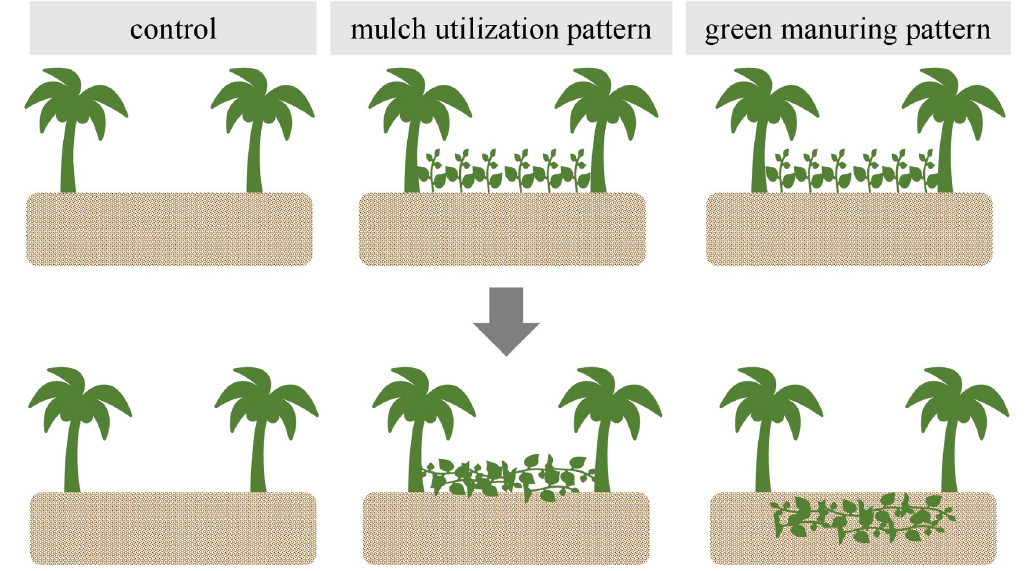
Fig 1. Pictorial treatment details of field